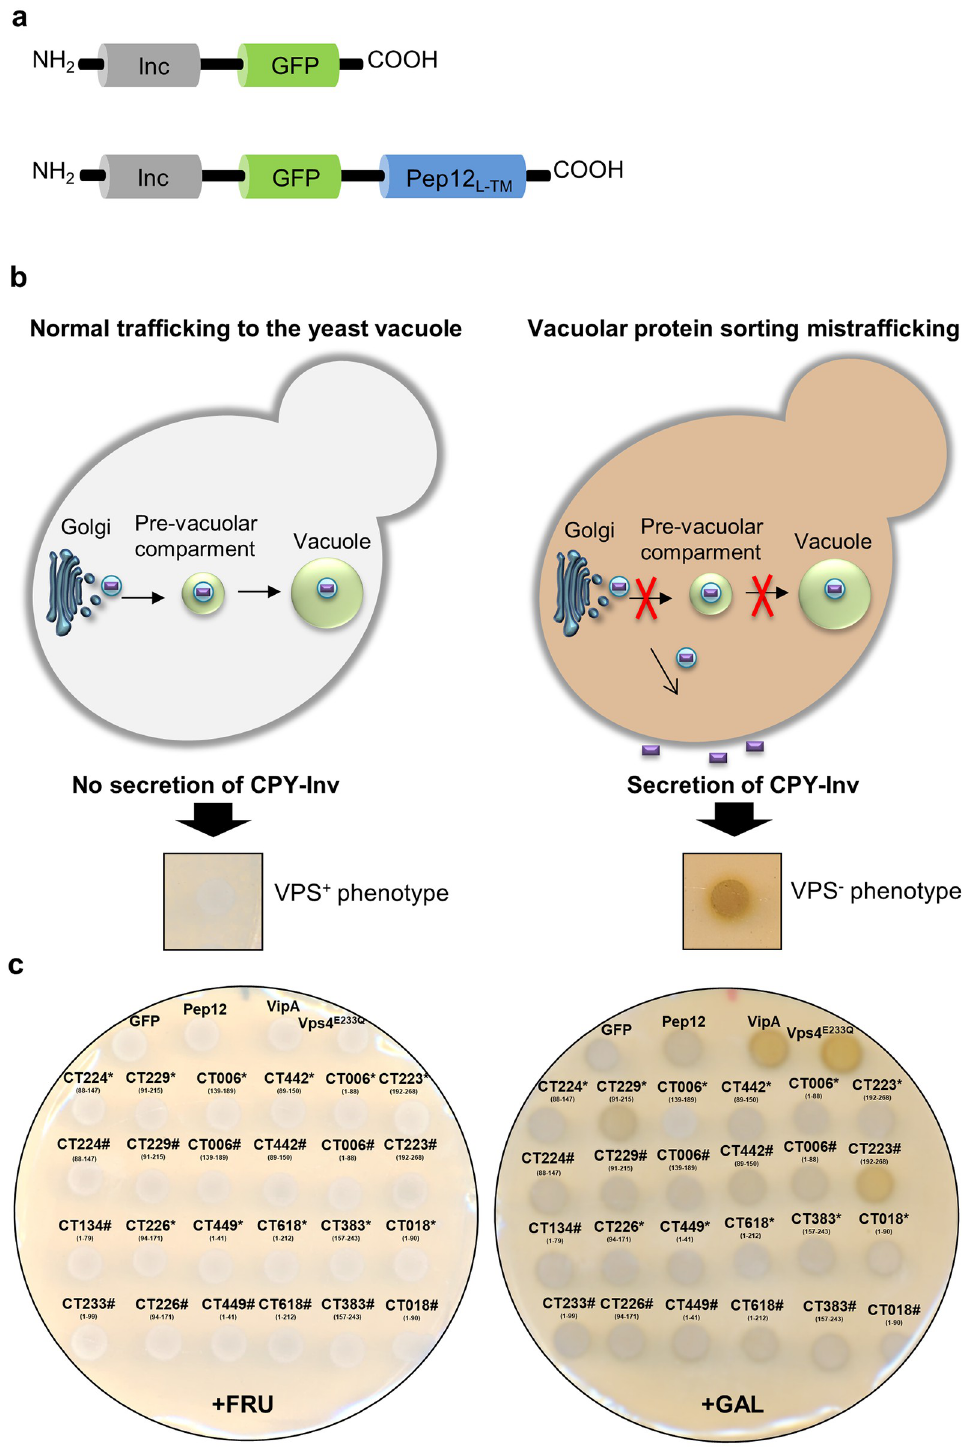
Fig 1. C . trachomatis Incs cause vacuolar protein sorting mistrafficking in yeast. (a) Schematic representation of the fusion proteins used in vacuolar protein sorting (Vps) assays in Saccharomyces cerevisiae . The S . cerevisiae NSY01 reporter strain (S1 Table) was transformed with plasmids encoding the predicted cytosolic domains of Incs fused to GFP (Inc-GFP) (left-hand side), or fused to GFP and also to the localization signal (L) and transmembrane domains (TM) of the yeast SNARE Pep12p (Inc-GFP-Pep12 L-TM ) (right-hand side), under the control of a galactose-inducible promoter.